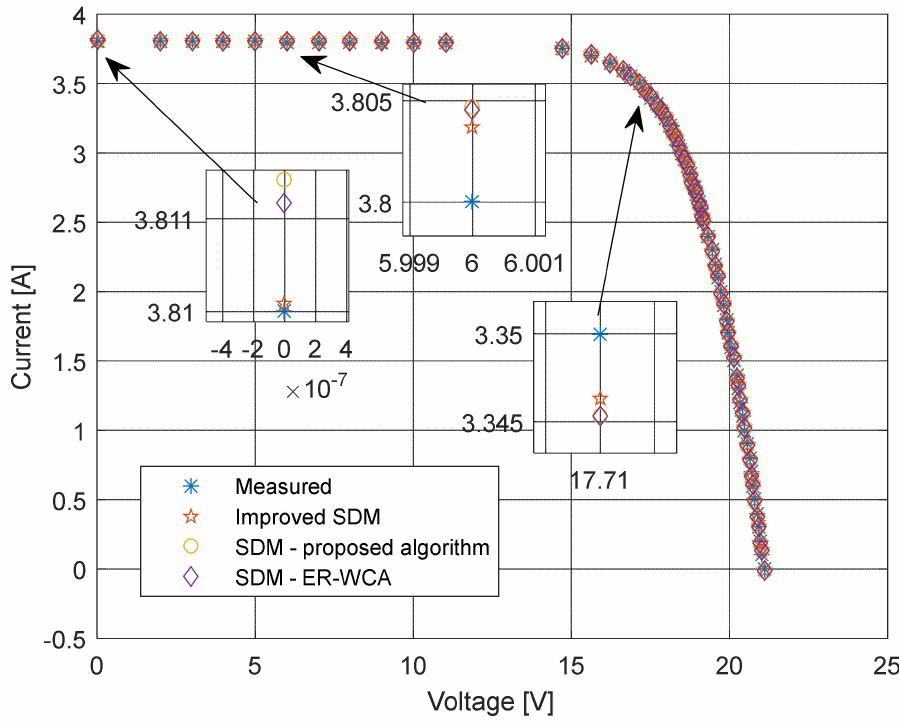
Figure 20. Current–voltage characteristics obtained using different methods for both SDM and